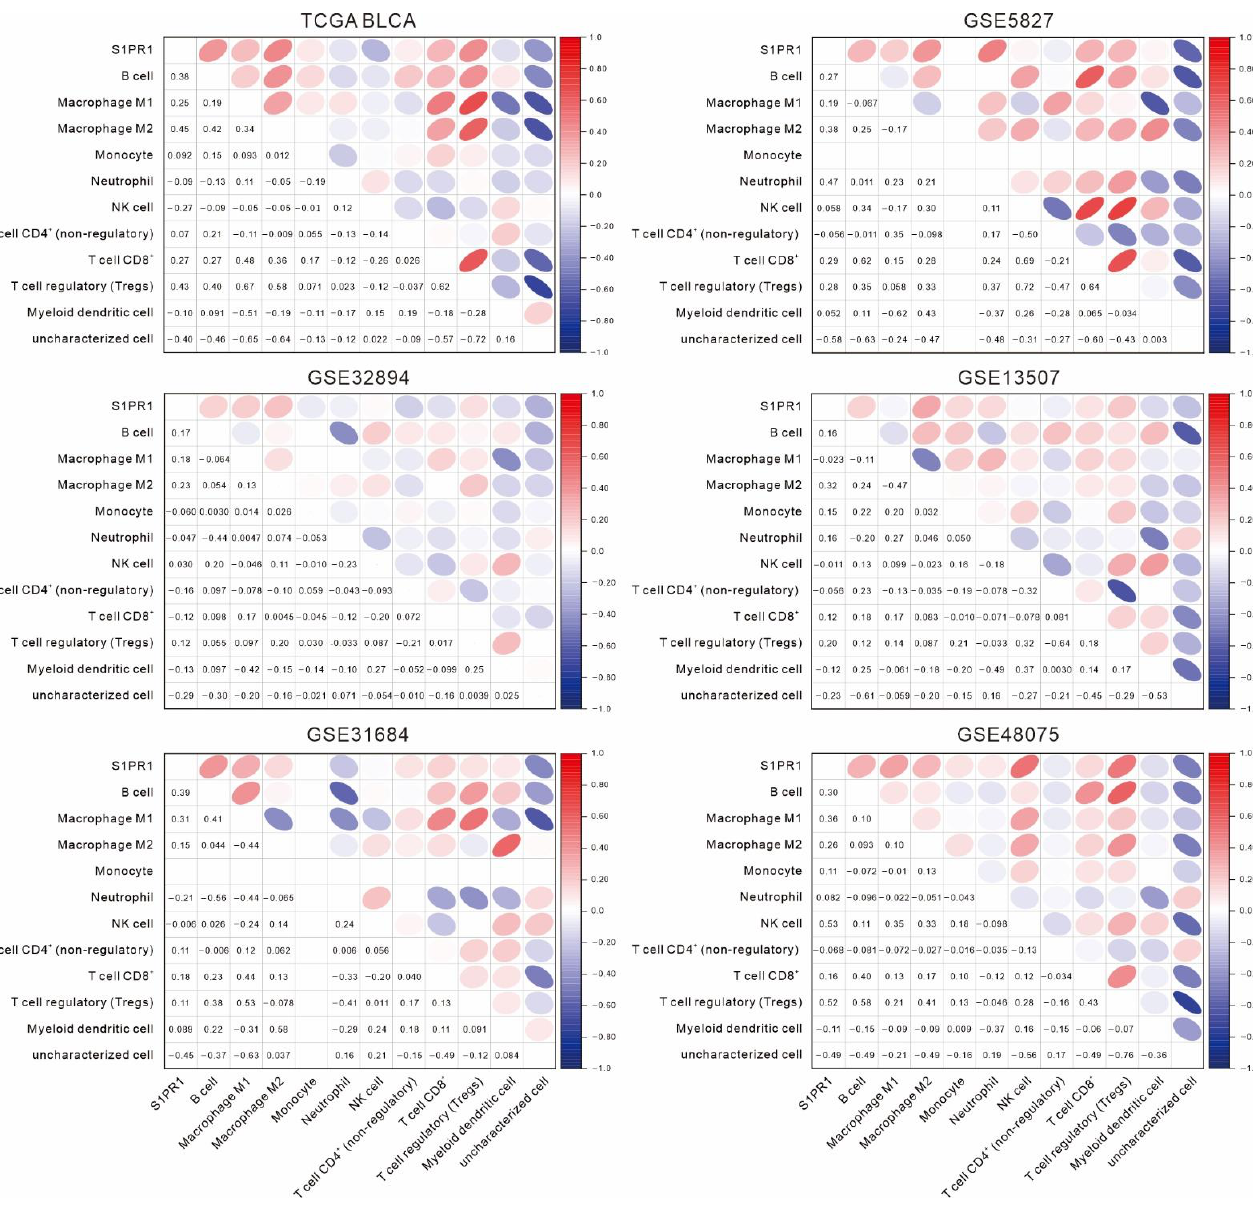
Figure 3. Association of S1PR1 expression with various immune cell infiltrations. The association of S1PR1 expression in bladder cancer tissues with QUANTISEQ simulated multiple immune cell infiltration was assessed using Spearman’s correlation.